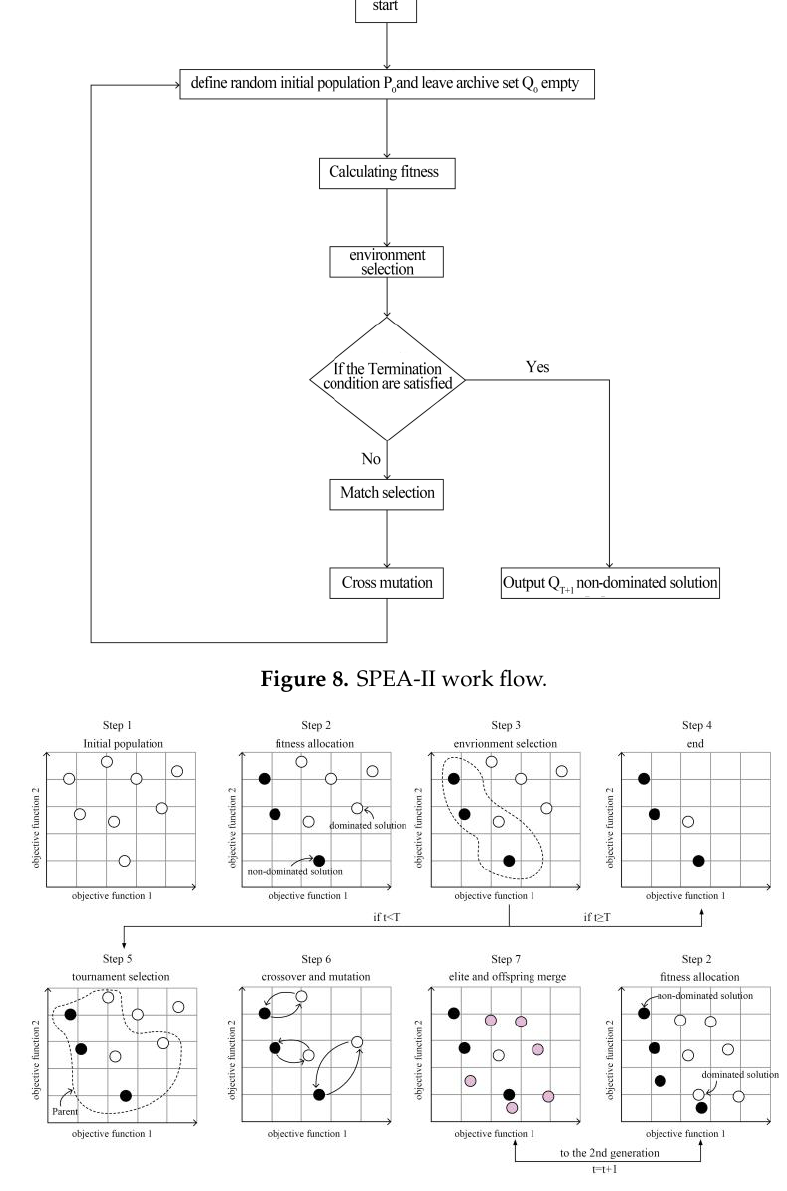
Figure 9. Diagram of SPEA-II algorithm work flow.